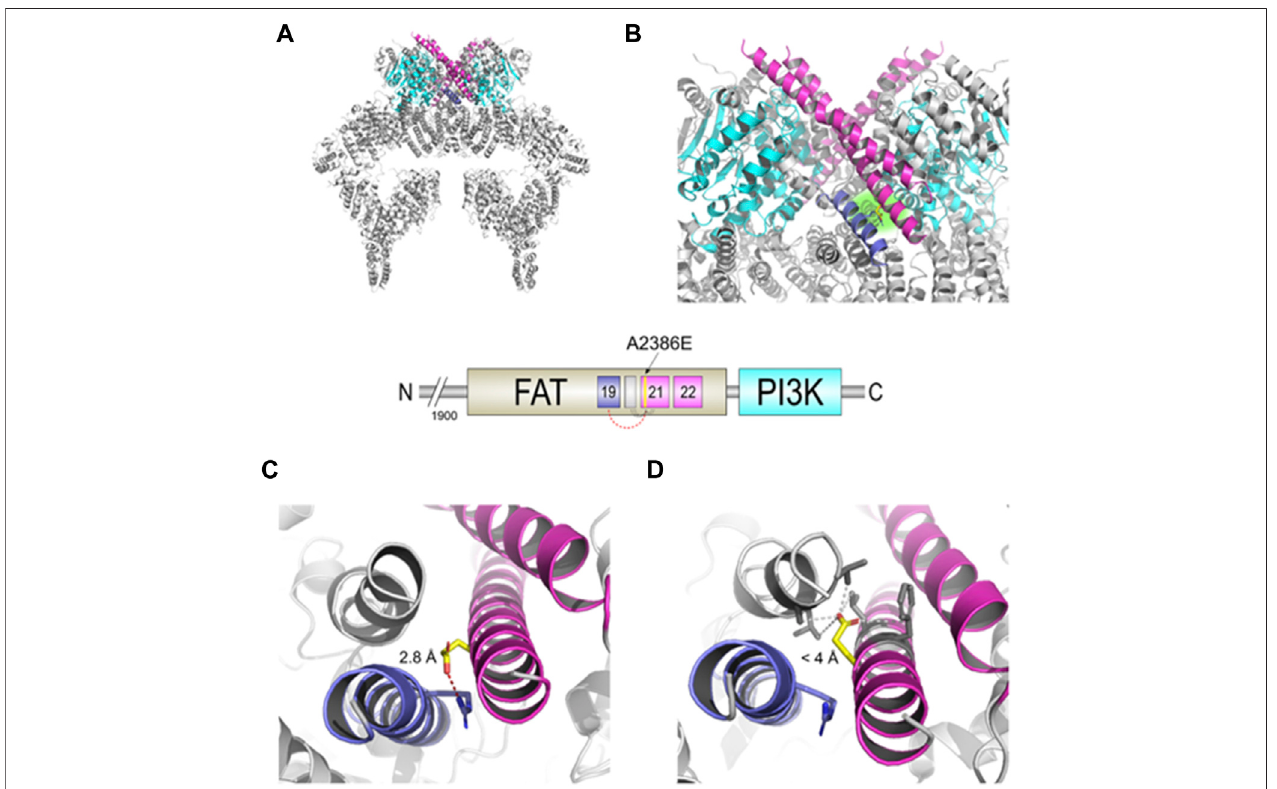
FIGURE2| StructuralchangespredictionoftheA2386EATMmutatedprotein.TheschemeinthecentreshowstheC-terminalFATandPI3KdomainsofATMwith the colour legend ofthe a helices and domains used in fi gures. (A) Structural model of the mutated ATM obtained with Missense3D using PDB ID 6K9L as template. (B) Zoomed-in catalytic domains of the protein; Glu2386 is highlighted in yellow sticks and with a green-faded background. (C) Structural detail of A2386E predicted by DynaMut. Red-dashed line shows the distance of 2.8 Å between Glu2386 and Arg2339. (D) Structural detail of the mutant A2386E predicted by Missense3D. Grey-dashed lines show the distances < 4 Å between Glu 2386 and the hydrophobic